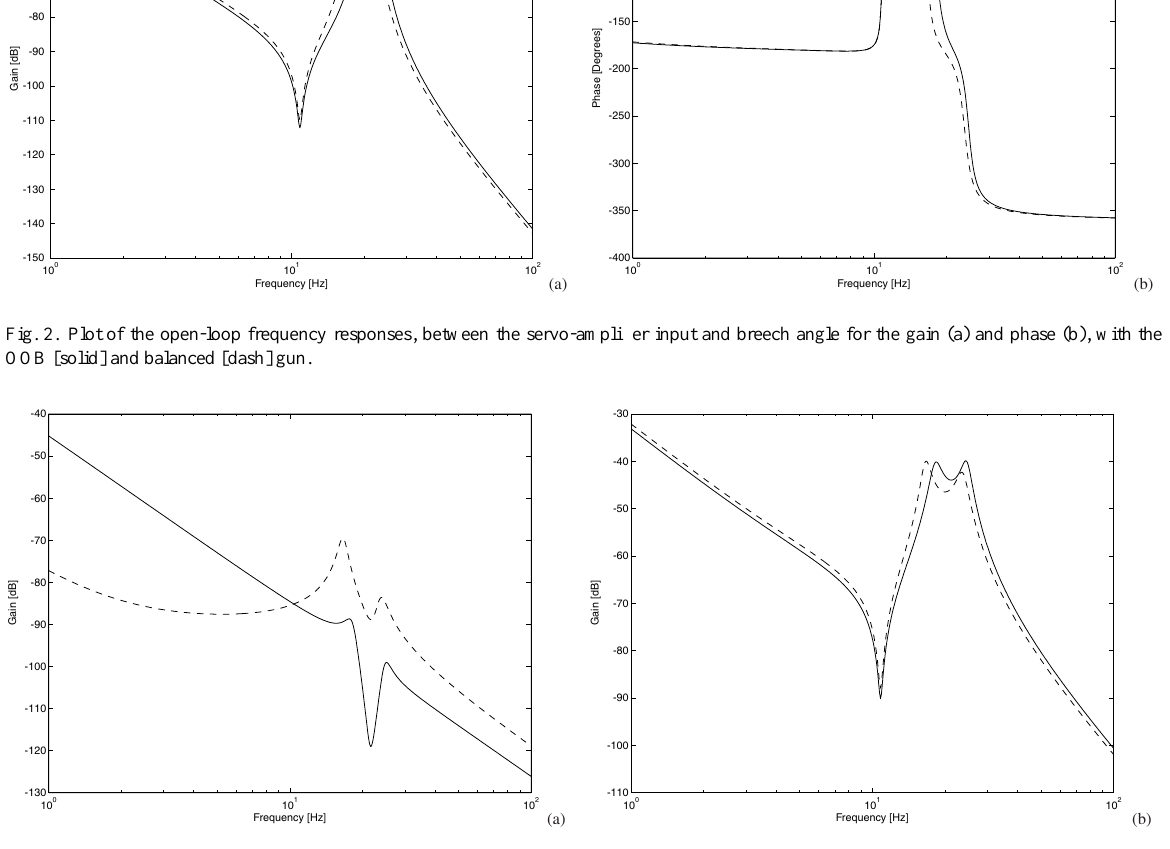
Fig. 3. Plot of the disturbance response of the elevation model breech angle to the trunnion vertical acceleration (a) and hull pitch rate (b), with the OOB [solid] and balanced [dash]